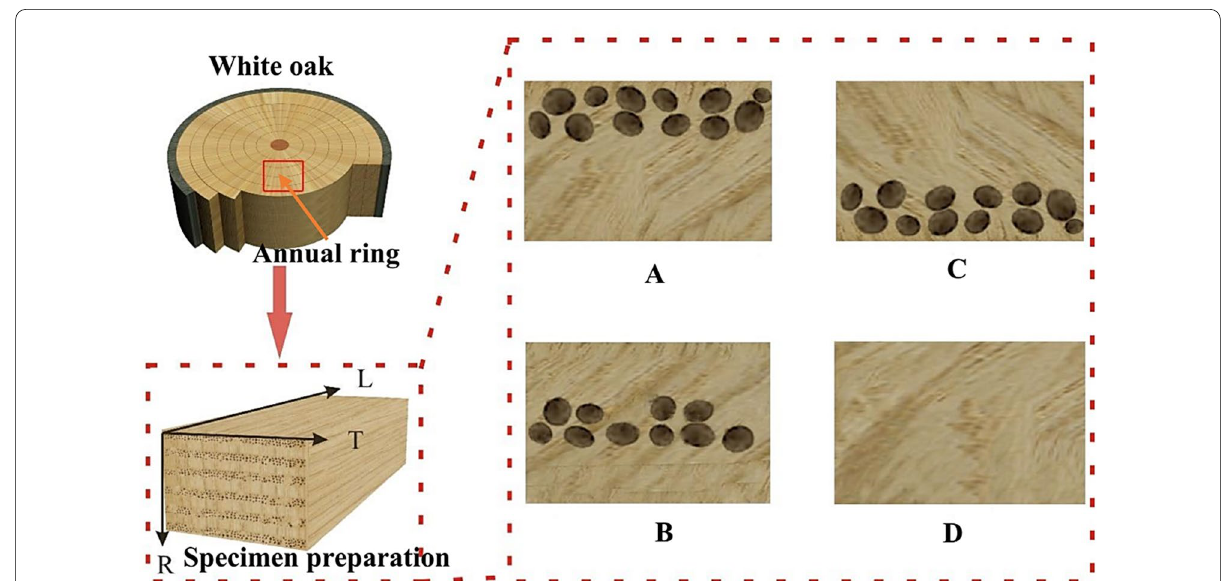
Fig. 1 Specimen preparation: Specimen A is the specimen with earlywood vessel belt on the stress surface, B is the specimen with earlywood vessel belt in the middle part, C is the specimen with earlywood vessel belt on the back-stress surface and D is the control specimen